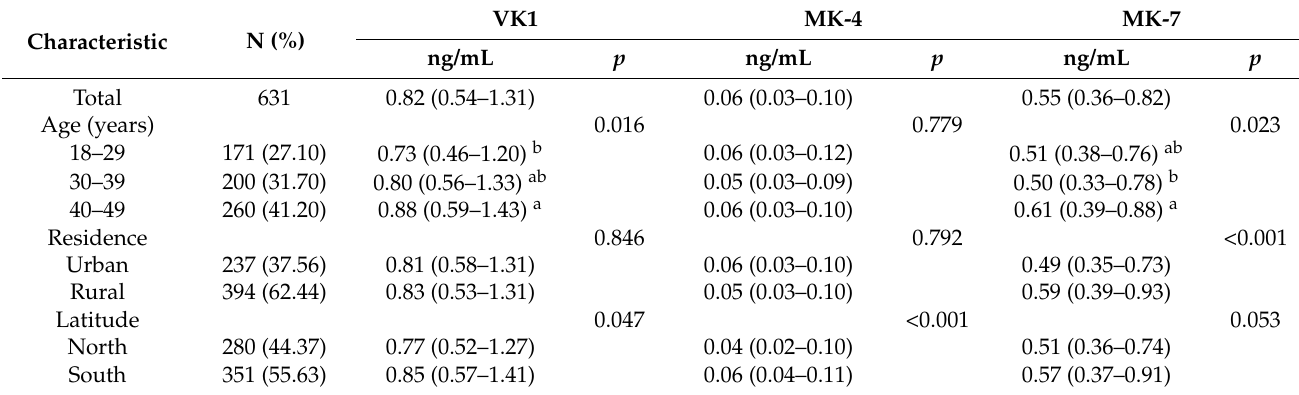
Table 3. Concentration of vitamin K in serum.